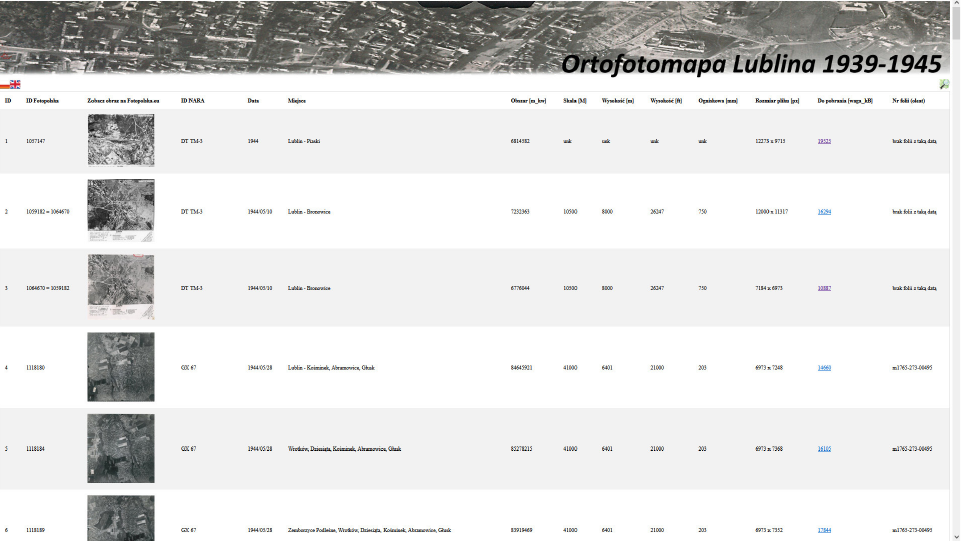
Fig. 9. ortolub.umcs.pl portal – the repository of downloadable images. Own